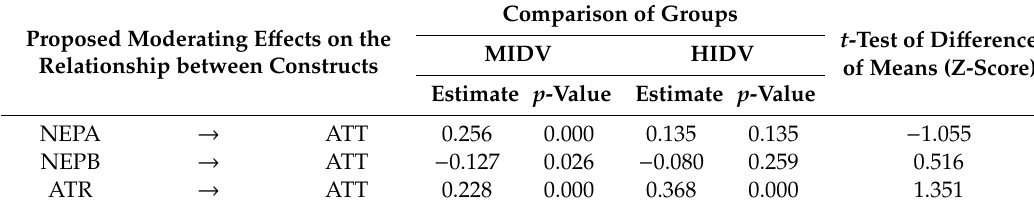
Table 9. Moderation analysis based on individualism (IDV)